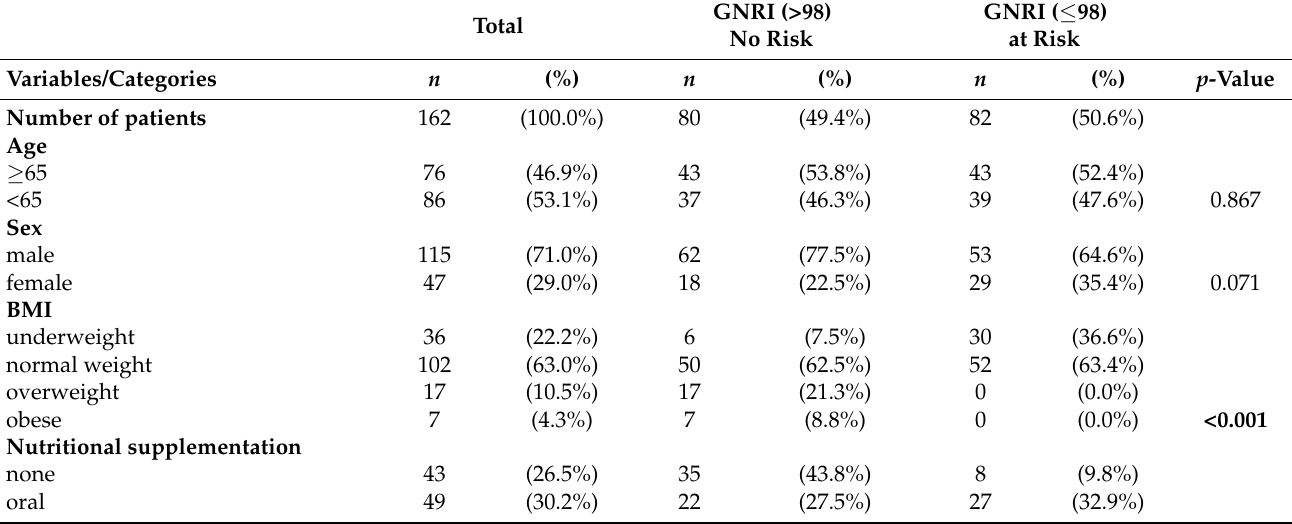
Table 1. Patient characteristics and demographics according to PFS-optimized GNRI groups. Distri- bution of GNRI > 98 (no risk) and GNRI ≤ 98 (at risk) was analyzed using Chi-squared or Fisher’s exact